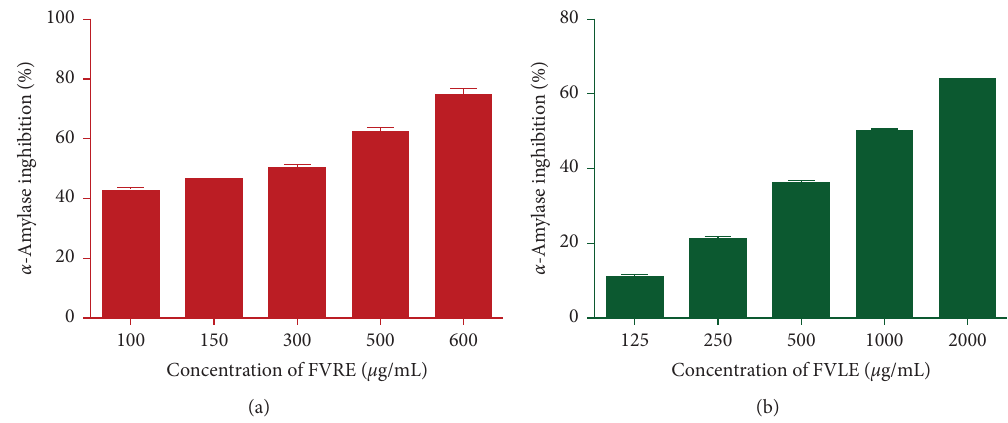
Figure 4: Percentage of α -amylase inhibition versus different concentrations of F. vulgare leaf and rootstock aqueous